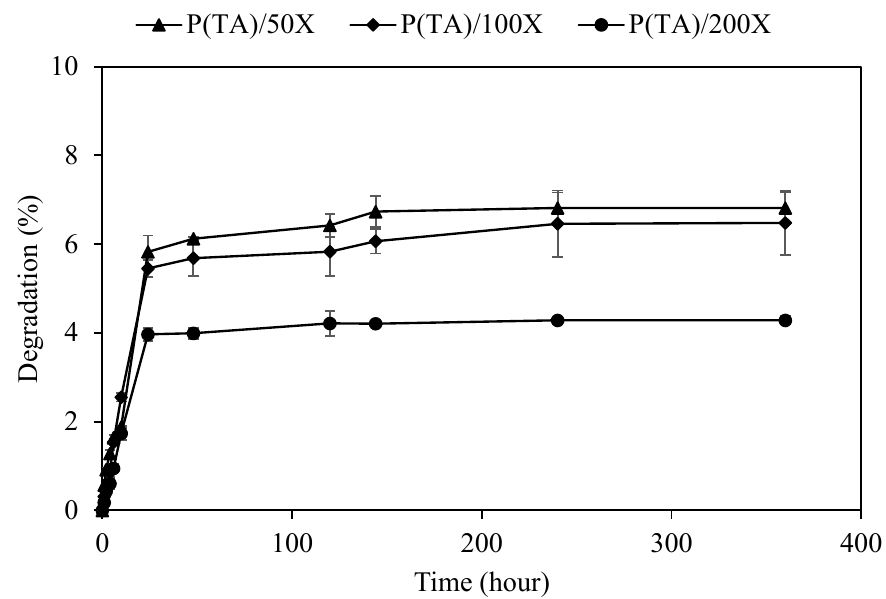
Figure 4. Hydrolytic degradation of p (TA) particles in pH 7.4, PBS solution prepared at different crosslinking ratios.